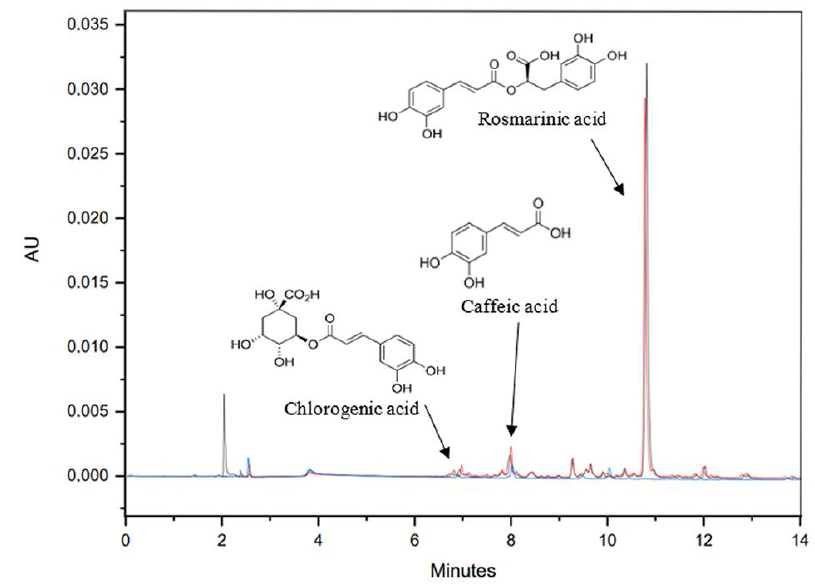
Figure 6 Chromatogram. Peak 1 CHA (T R = 6.94 min, λ = 324 nm), peak 2 CAF (T R = 7.98 min, λ = 324 nm) and peak 3 RA (T R = 10.79 min, λ = 324 nm). PV fraction line red, DV fraction line black, FS λ = 324 nm) and peak 3 RA (T λ = 324 nm). PV fraction line red, DV fraction line black, R = 10.79 min, FS fraction line